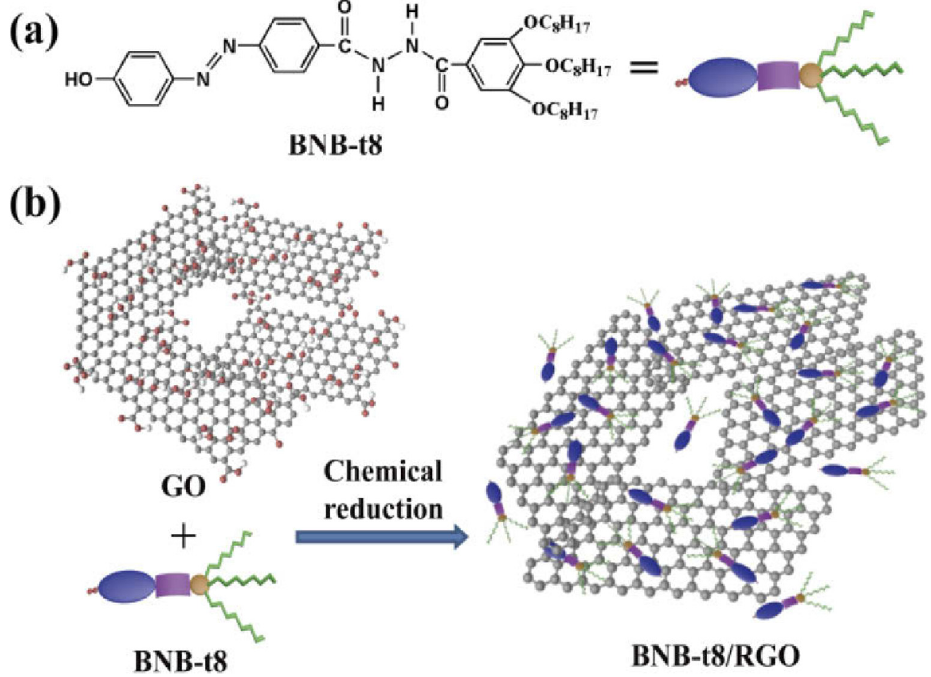
Figure 15. Synthesis of BNB-t8-RGO composites by π - π stacking [111]. ( a ) Molecular structure of BNB-t8. ( b ) Schematic representation showing the preparation of BNB-t8/RGO hybrids